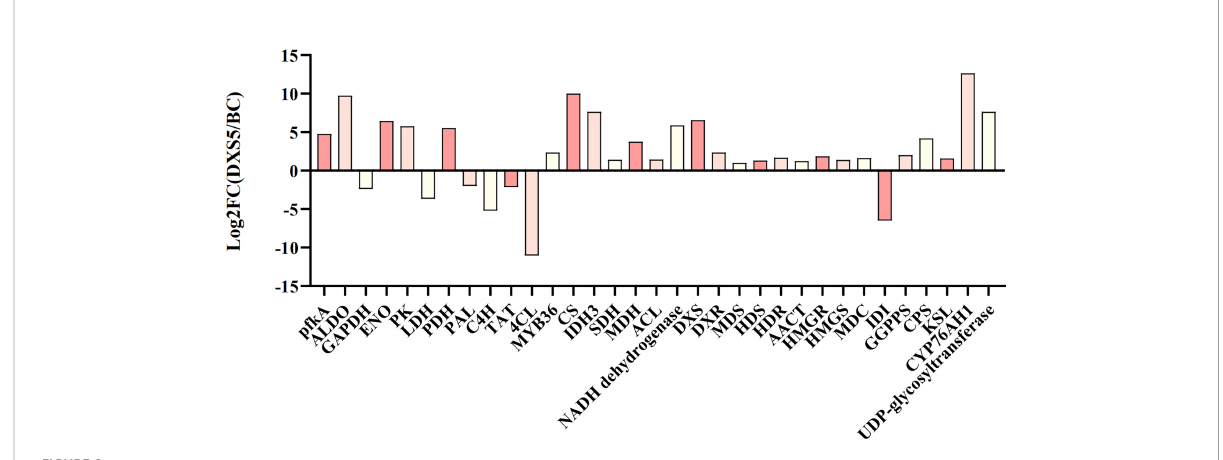
FIGURE 9 Log2FC value distribution of differentially expressed genes (DEGs).